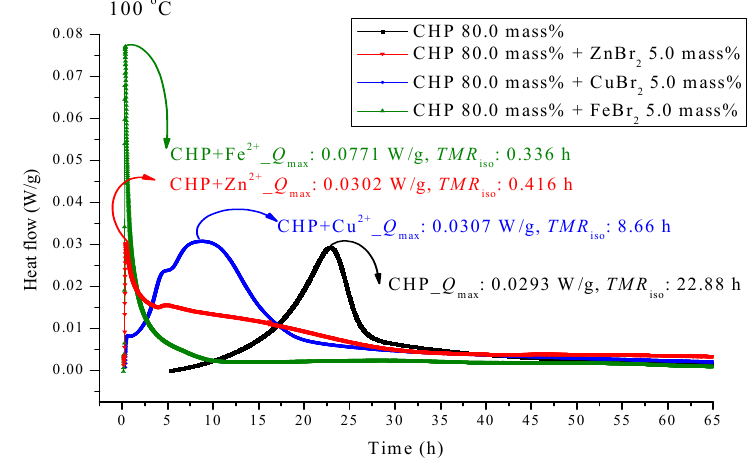
Figure 4. Heat flow versus temperature plot for 80.0 mass% CHP mixed with ZnBr 2 , CuBr 2 or FeBr 2 , tested using TAM III scanning analysis at 100.0 °C.